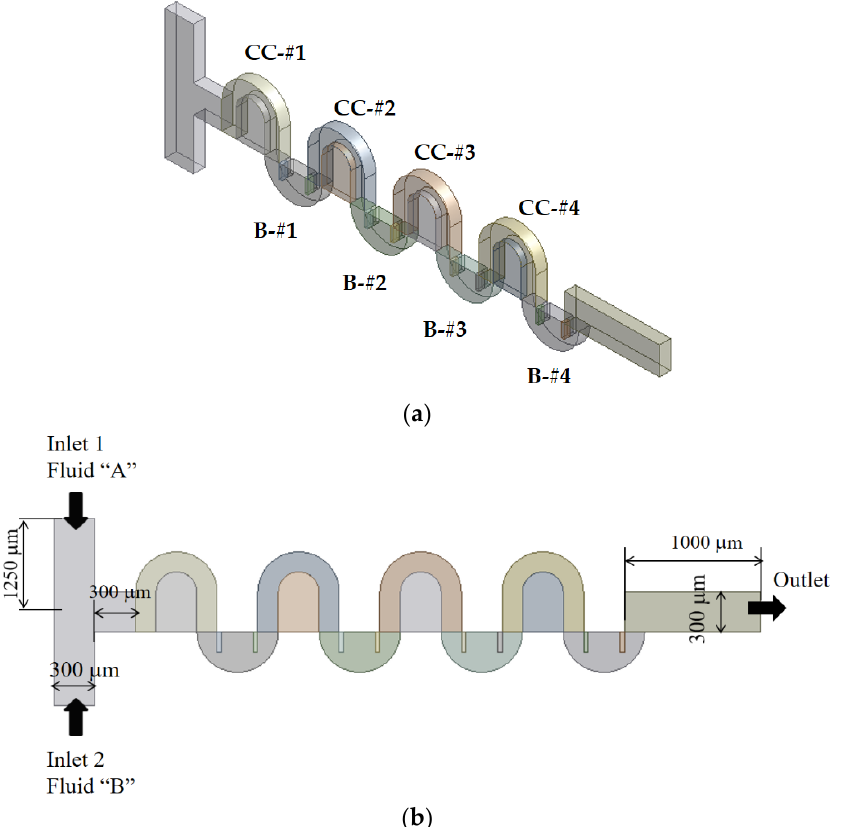
Figure 1. Schematic diagram of two submerged structures (non-proportional): ( a ) Norman window and ( b ) Rectangular baffles.